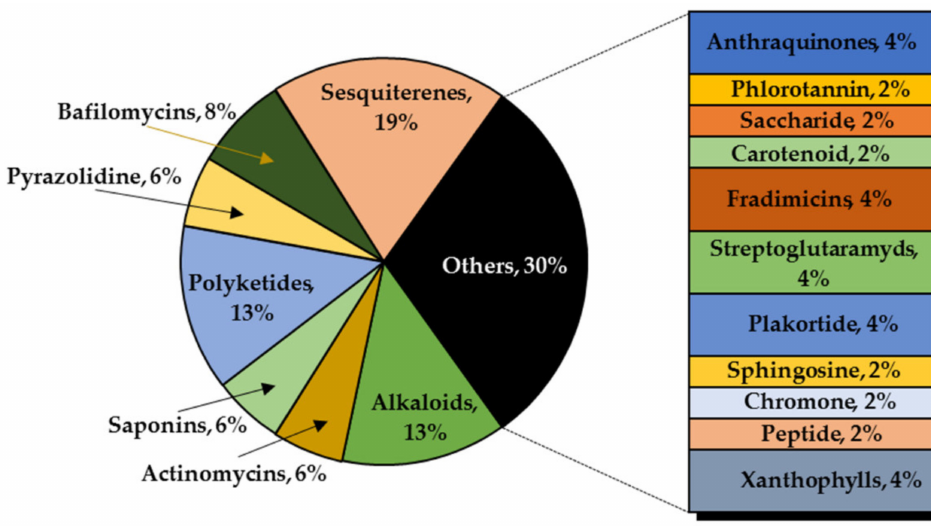
Figure 21. Most significant chemical classes of anti-glioma